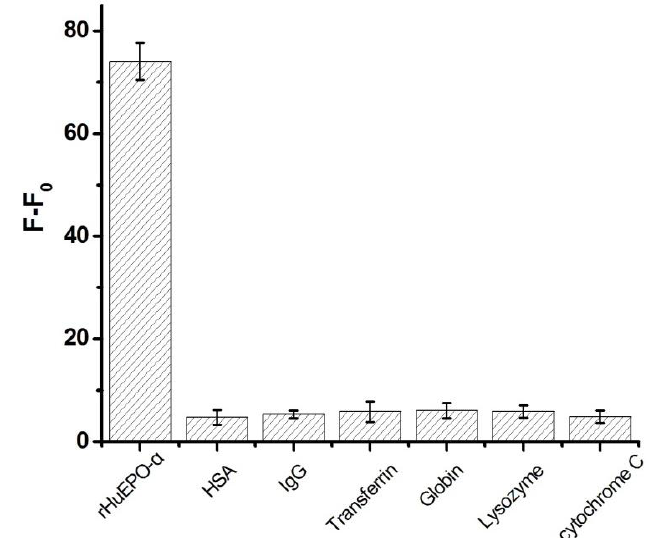
Figure 7. Specificity of the Apt-AuNPs probe, which is reflected by the fluorescence responses (F-F ) of the Apt-AuNPs probe in the presence of 100 nM rHuEPO-α in the 0 presence of 1.0 μM of different interfering proteins. Each point reflects the average of three independent experiments. Error bars indicate standard